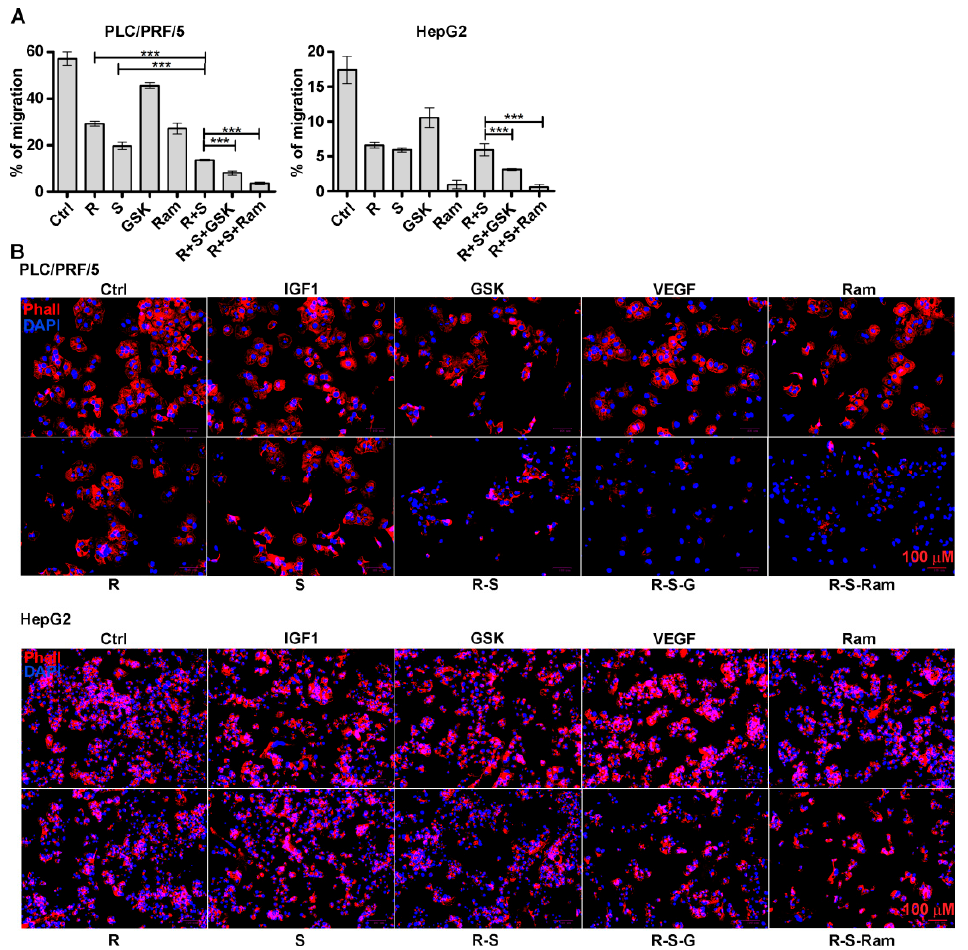
Figure 4. GSK1838705A and ramucirumab potentiate the inhibitory effects of sorafenib/regorafenib combination on HCC cell motility and depolymerization of actin cytoskeleton. Cells were cultured with 2.5 μ M (PLC/PRF/5) or 1 μ M (HepG2) sorafenib, 1 μ M (PLC/PRF/5) or 0.1 μ M (HepG2) regorafenib, 3 μ M GSK1838705A and 400 μ M ramucirumab administrated singularly or in combination. ( A ) Migration assay in PLC / PRF / 5 and HepG2 cultured on fibronectin coated wells. The percentage of migration were